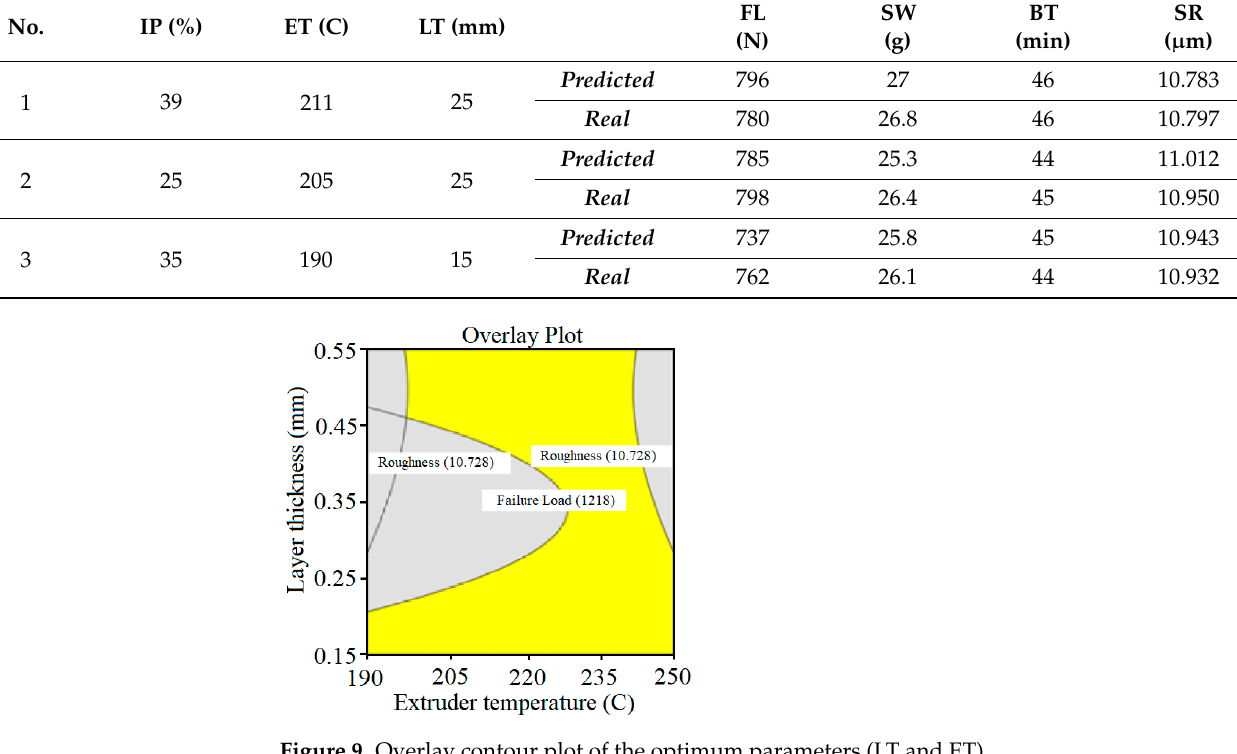
Figure 9. Overlay contour plot of the optimum parameters (LT and ET).